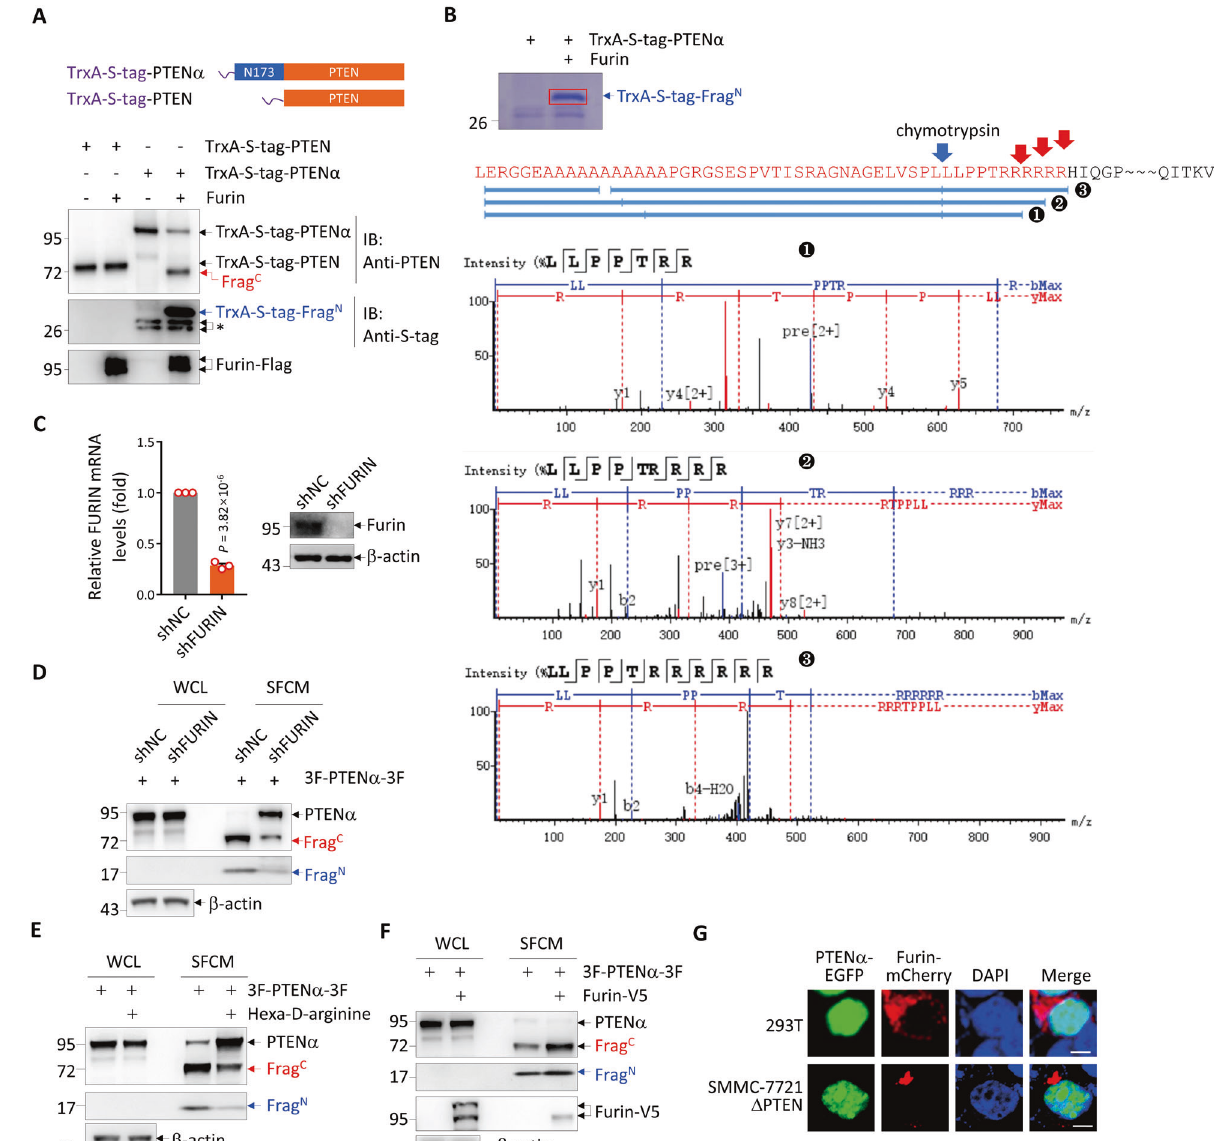
Fig. 3 PTEN α is cleaved by Furin. A Bacterially puri fi ed TrxA-S-tag-PTEN or TrxA-S-tag-PTEN α (top) were incubated with Flag-tagged Furin puri fi ed from 293 T cells, followed by Western blot analysis for the indicated proteins (bottom). Asterisk points to two unknown bands. B PTEN α was incubated with Furin as in A and the protein products were separated by electrophoresis and stained with Coomassie brilliant blue (top). The Frag N band was cut from the gel and subjected to mass spectrometry analysis after digestion by chymotrypsin. Red arrows indicate the Furin-cleavage sites predicted from three peptides with their tandem mass spectrums shown (bottom). C qRT-PCR analysis of FURIN mRNA (left) and Western blot analysis for Furin protein (right) in PTEN -knockout SMMC-7721 cells with and without knockdown of FURIN by shRNA. Data are presented as the means ± SEM ( n = 3 independent experiments; two-tailed unpaired t -test with P value shown). D Western blot analysis for the indicated proteins in the WCL and SFCM of 3F-PTEN α -3F-expressing PTEN -knockout SMMC-7721 cells with and without knockdown of FURIN . E , F Western blot analysis for the indicated proteins in the WCL and SFCM of 3F-PTEN α -3F-expressing PTEN -knockout SMMC-7721 cells with and without treatment by 1 μ M Hexa-D-arginine ( E ), and overexpression of V5-tagged Furin ( F ). G Representative images of EGFP-tagged PTEN α and mCherry-tagged Furin co-transfected in 293 T or PTEN -knockout SMMC-7721 cells with re-staining of DAPI. Scale bar represents 10 μ m. 3 F 3×Flag, WCL whole-cell lysate, SFCM serum-free conditioned medium, NC negative control. cleavage of extracellular PTEN α (Fig. 3D). In line, treatment with and an antibody recognizing the S-tag fused to the N-terminus of Furin inhibitor hexa-D-arginine [19] showed the similar effect PTEN α (Fig. 3A). Mass spectrometry analysis of the Frag N (Fig. 3E). On the contrary, exogenous transfection of Furin, which con fi rmed that it matched with the N-terminus of PTEN α which increased intracellular Furin and its level in the extracellular space, ended within the polyarginine stretch (Fig. 3B). further enhanced the cleavage of extracellular PTEN α (Fig. 3F). Next, we knocked down FURIN in 3F-PTEN α -3F-expressing PTEN - These results con fi rmed the involvement of Furin in PTEN α knockout SMMC-7721 cells. The knockdown ef fi ciency was veri fi ed cleavage at the cellular level. Collectively, we identi fi ed Furin to be by both quantitative real-time PCR and Western blot analysis responsible for PTEN α cleavage in the extracellular space. (Fig. 3C). As expected, FURIN knockdown greatly reduced the Cell Death and Disease (2022)